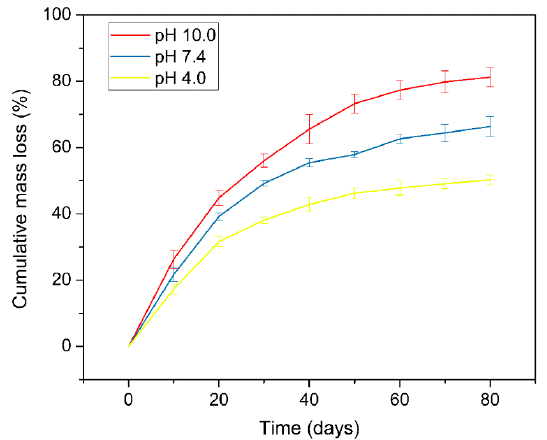
Figure 7. Mass loss of ZnO NPs-PDA-SS/PVA films under different pH conditions.